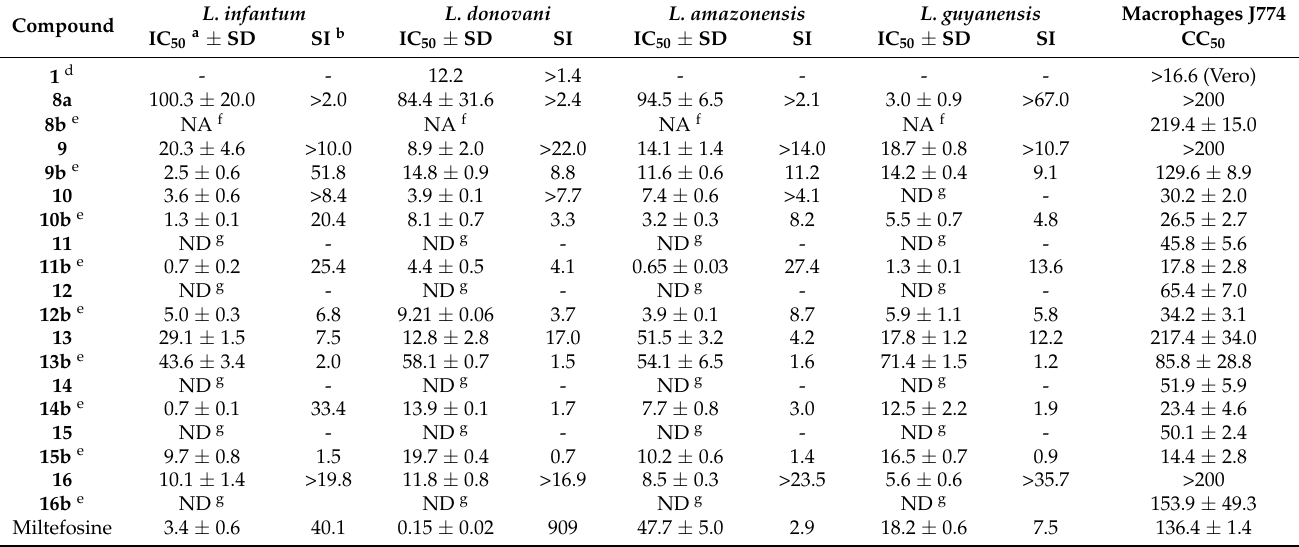
Table 1. Antileishmanial and cytotoxicity (IC 50 in µ M) of C19-functionalized ferruginol and sugiol analogs on in vitro promastigote